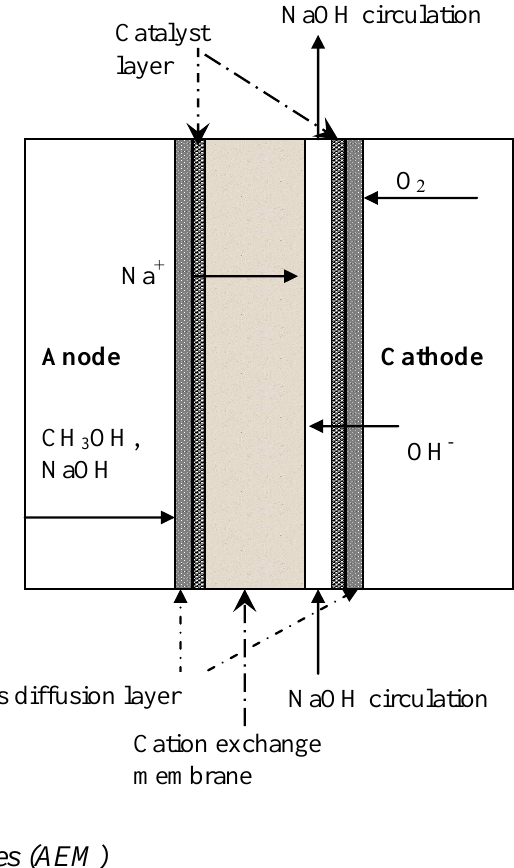
Figure 3. Schematic diagram of DMAFC with cation exchange membrane and incorporating an electrolyte circulating layer in the cathode compartment